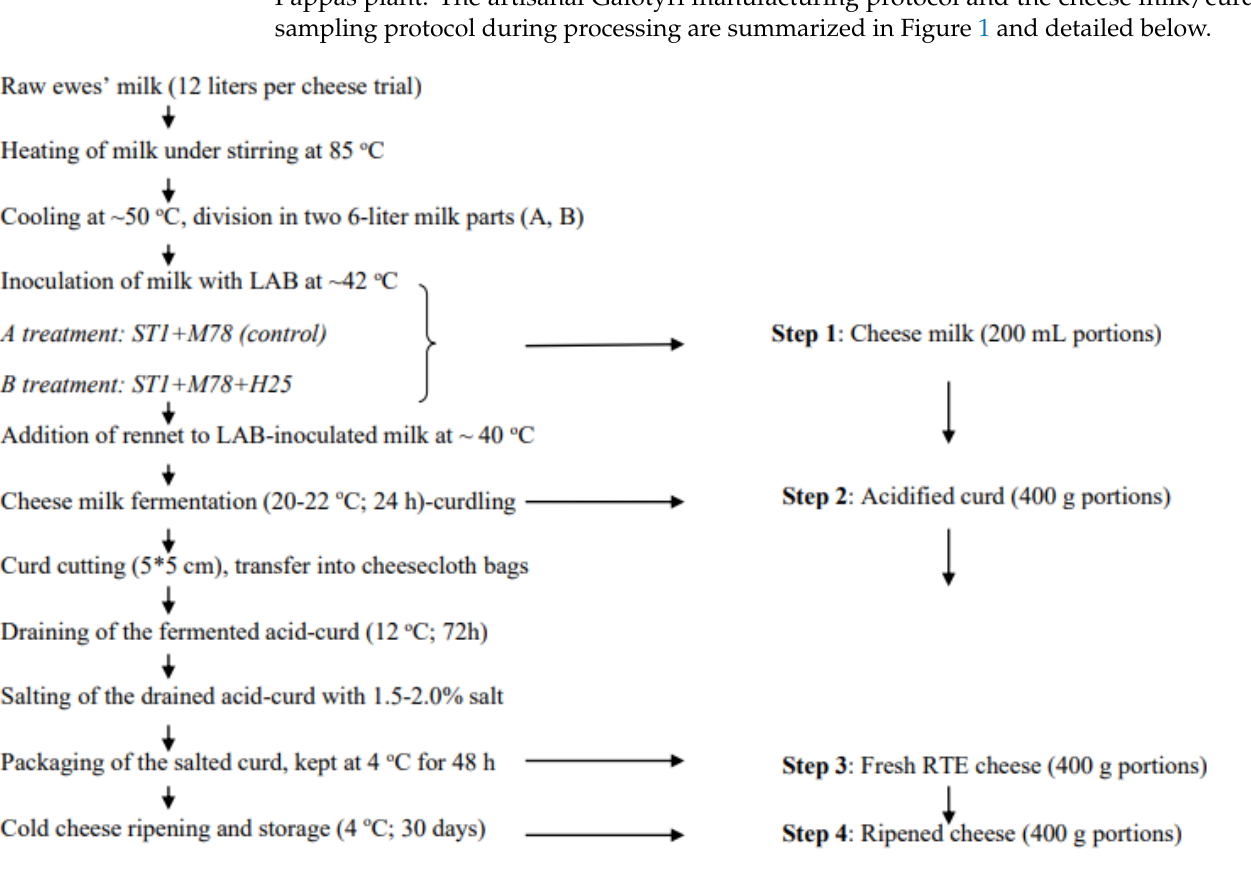
Figure 1. Artisanal Galotyri PDO cheese processing and sampling protocol. For each experimental cheese trial, 12 L of raw ewes’ milk obtained from local farmers was heated slowly in a stainless steel vessel at 85 ◦ C over a gas burner under continuous stirring. The temperature was recorded with a probe thermometer. The milk vessel was then placed into a basin with cold running water to accelerate cooling. When the temperature fell to 50 ◦ C, the milk was divided in two 6 L portions in two small (10 kg) plastic (trial 1) or stainless steel (trials 2 and 3) buckets with lids. At 42 ◦ C, the milk was inoculated with appropriate volumes of fresh (24 h) LAB cultures in RSM to obtain approximate inoculation levels of 6.5 to 7.0 log CFU/mL for S. thermophilus ST1, 6.0 to 6.5 log CFU/mL for Lc. lactis subsp. cremoris M78, and 5.5 to 6.0 log CFU/mL for L. plantarum H25. In the first bucket, strains ST1 and M78 were added as the basic starter culture (ST1+M78; Galotyri A/control), whereas in the second bucket the H25 adjunct strain was added after inoculation with the basic starter ST1+M78 culture (Galotyri B; new product). Then, each of the three Galotyri A batch trials inoculated with the basic starter ST1+M78 (A1, A2, and A3) was processed further, sampled, analyzed in parallel, and compared with each of the corresponding Galotyri B batch trials (B1, B2, and B3) containing the ST1+M78+H25 combination, as follows: The LAB-inoculated cheese milks were stirred (step 1;